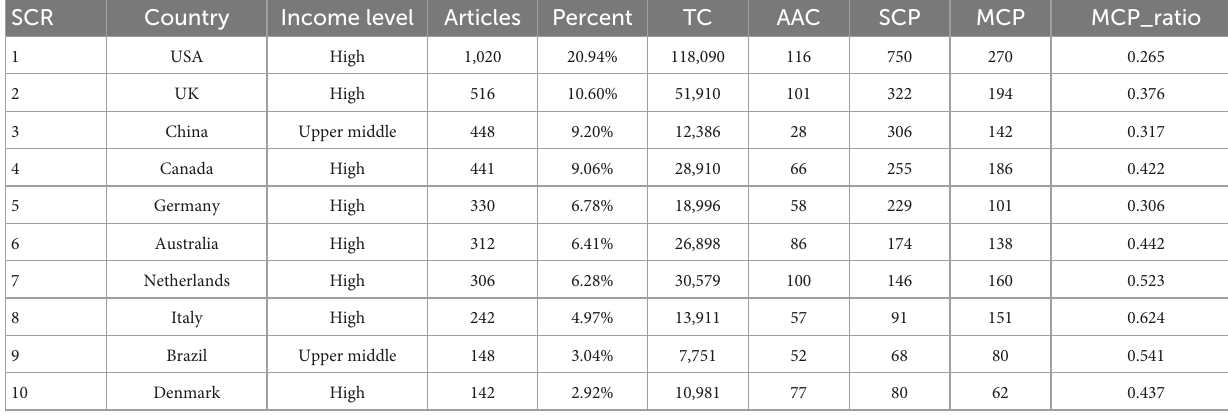
TABLE 1 Top 10 most productive countries of corresponding authors on MDD-related